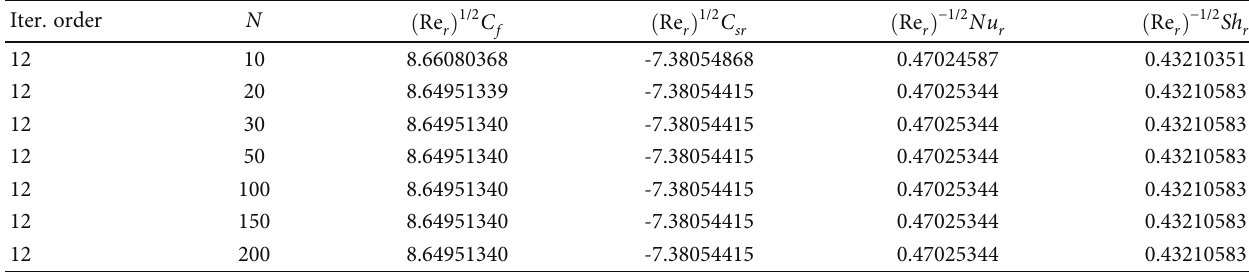
Table 2: Grid-independence test for SLLM solutions.